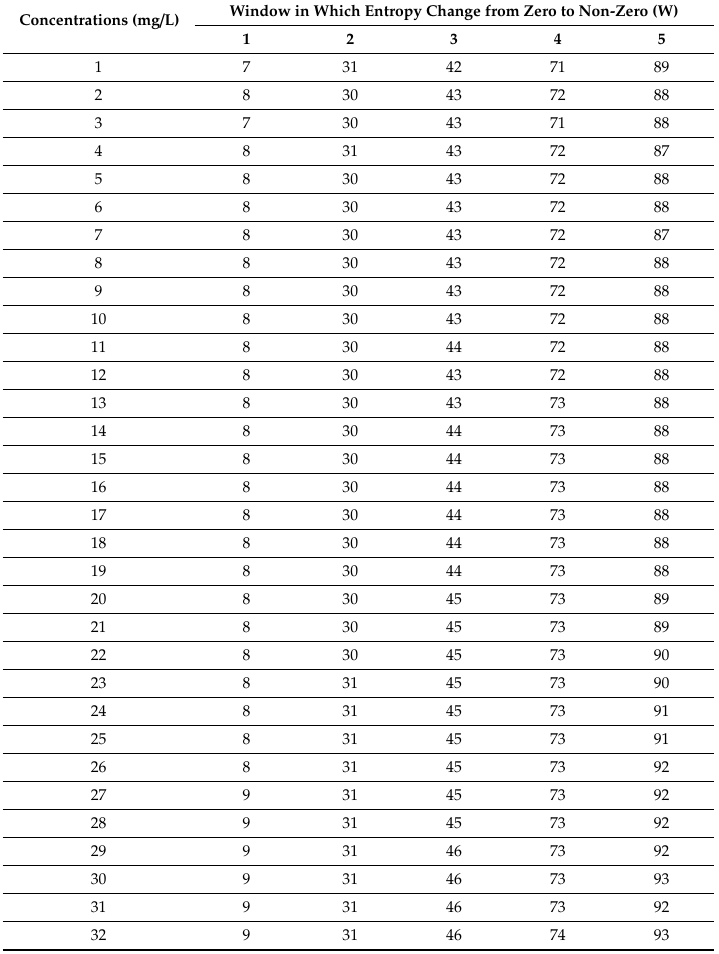
Table 2. The windows in which entropy change from zero to